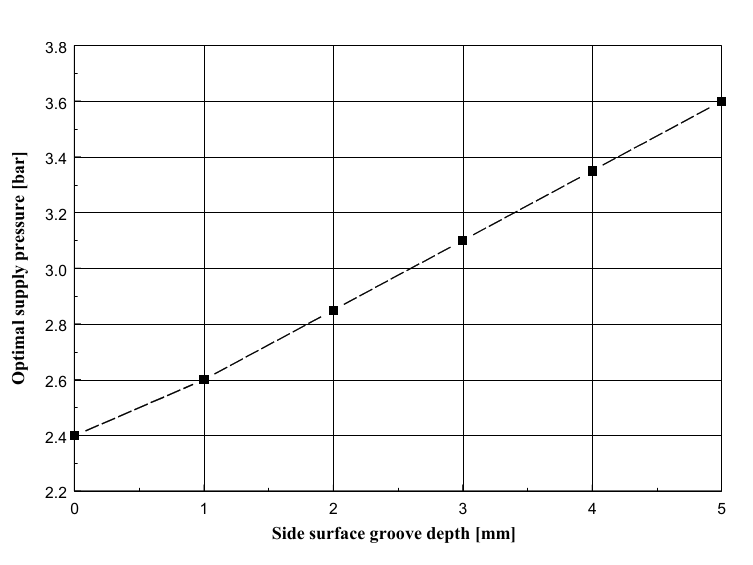
Table 2. Optimal supply pressure (elastic-plastic model) of regenerated sand. Maximum Depth of the Side Surface Optimal Supply Groove h (mm)